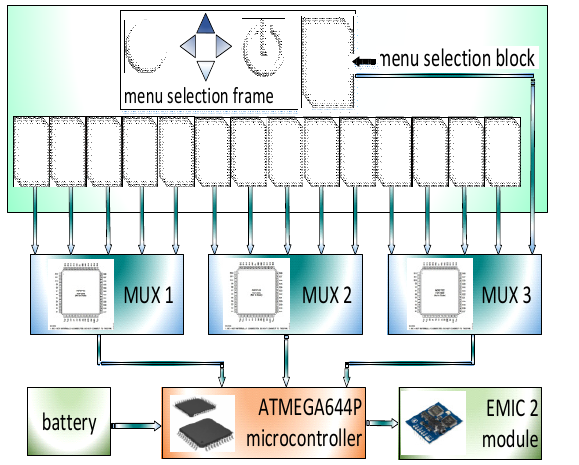
Fig. 2: Conceptual diagram and system layout.